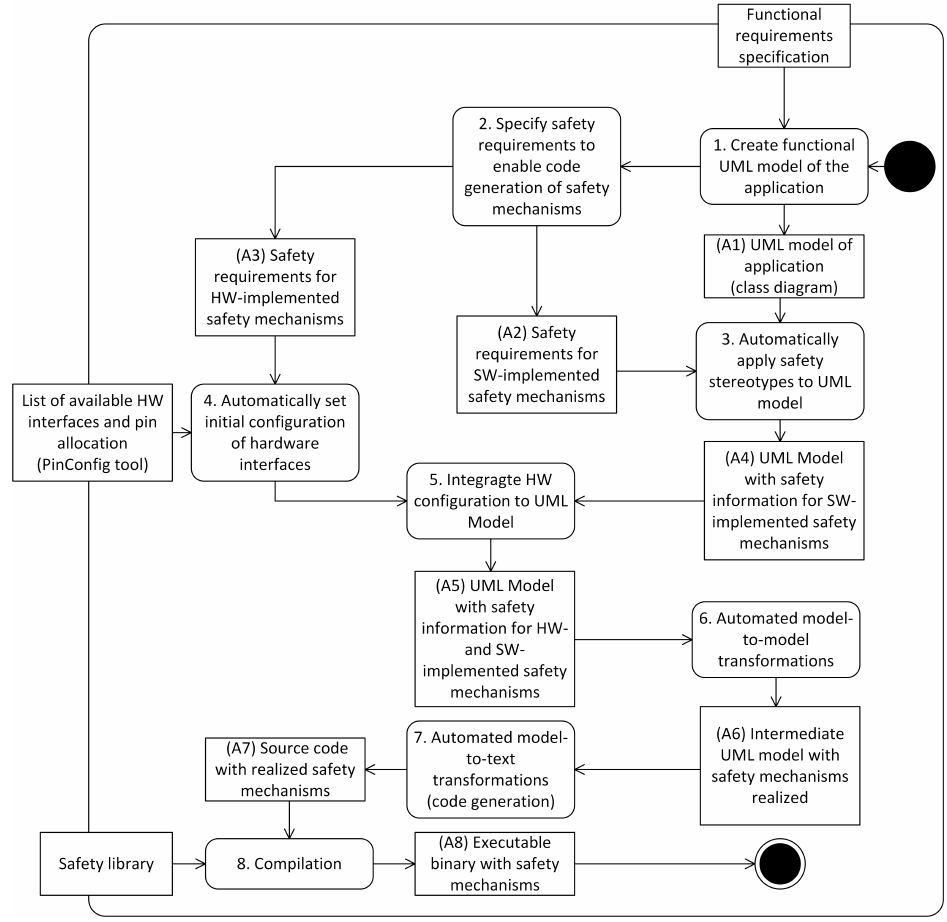
Figure 1. Workflow for the model-driven code generation of safety mechanisms (Unified Modeling Language (UML) 2.5 activity diagram